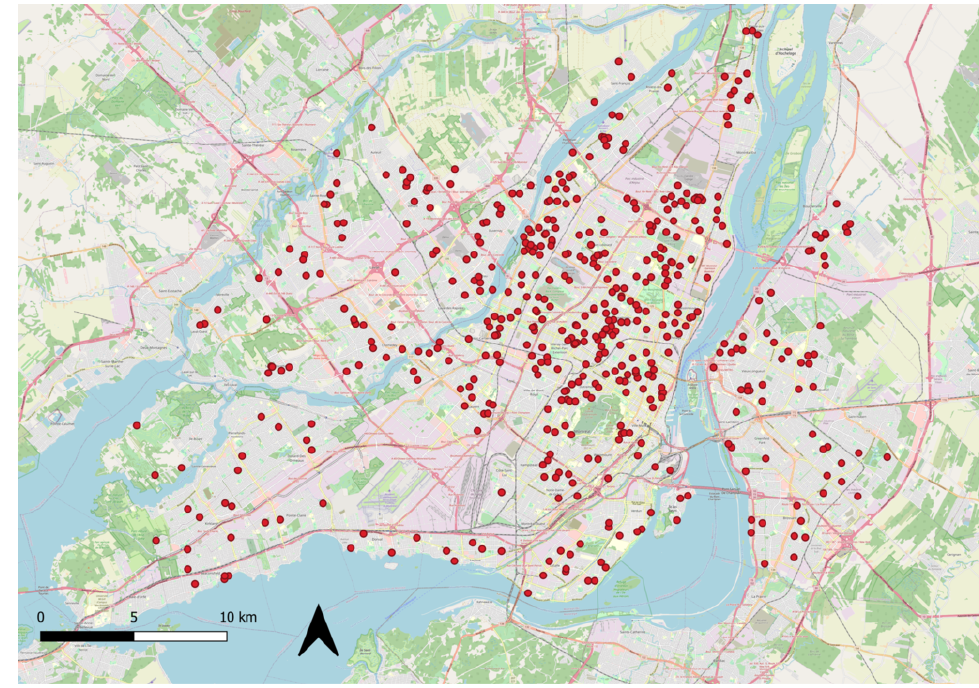
Figure 8. The location of the 500 sampling points across the city of